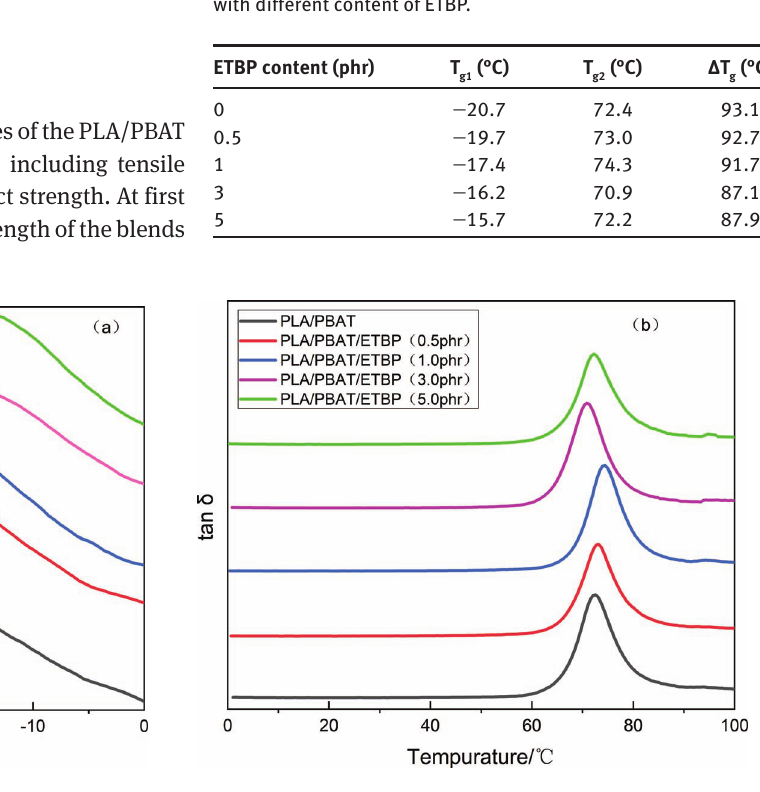
Table 1: Glass transition points of the PLA/PBAT